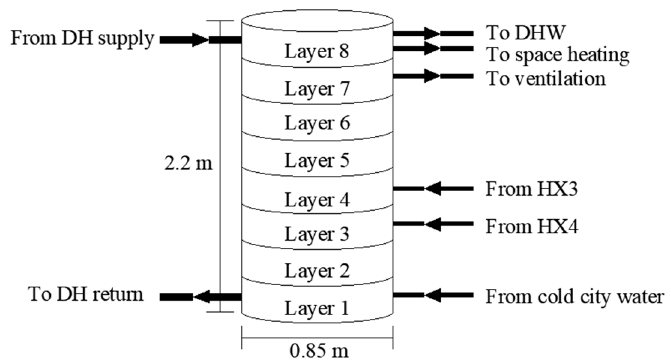
Figure 5. System layout of the storage tank.